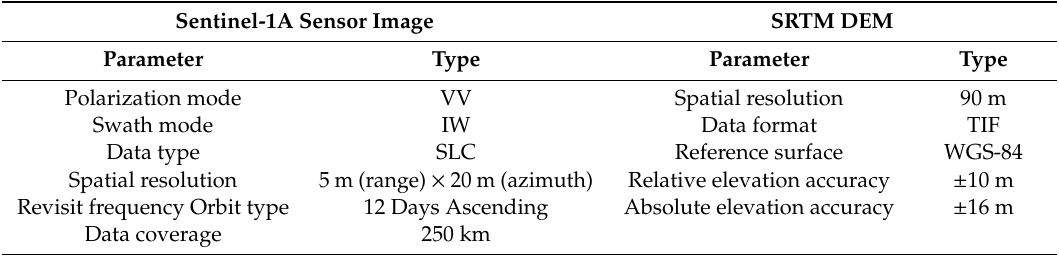
Table 1. Parameters of the Sentinel-1A sensor images and the Shuttle Radar Topographic Mission (SRTM) Digital Elevation Model (DEM) data used in this